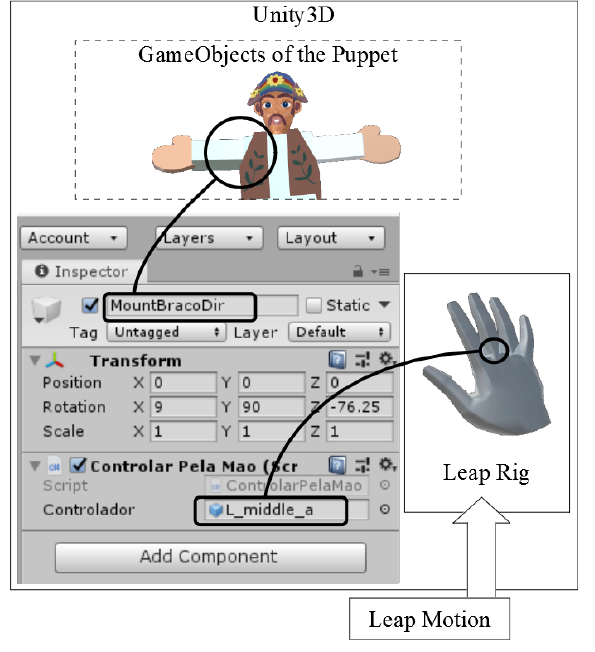
Figure 9. Rapid prototyping of the Virtual Puppet in Unity3D: with few lines of code, we can associate tracked hand with puppet's